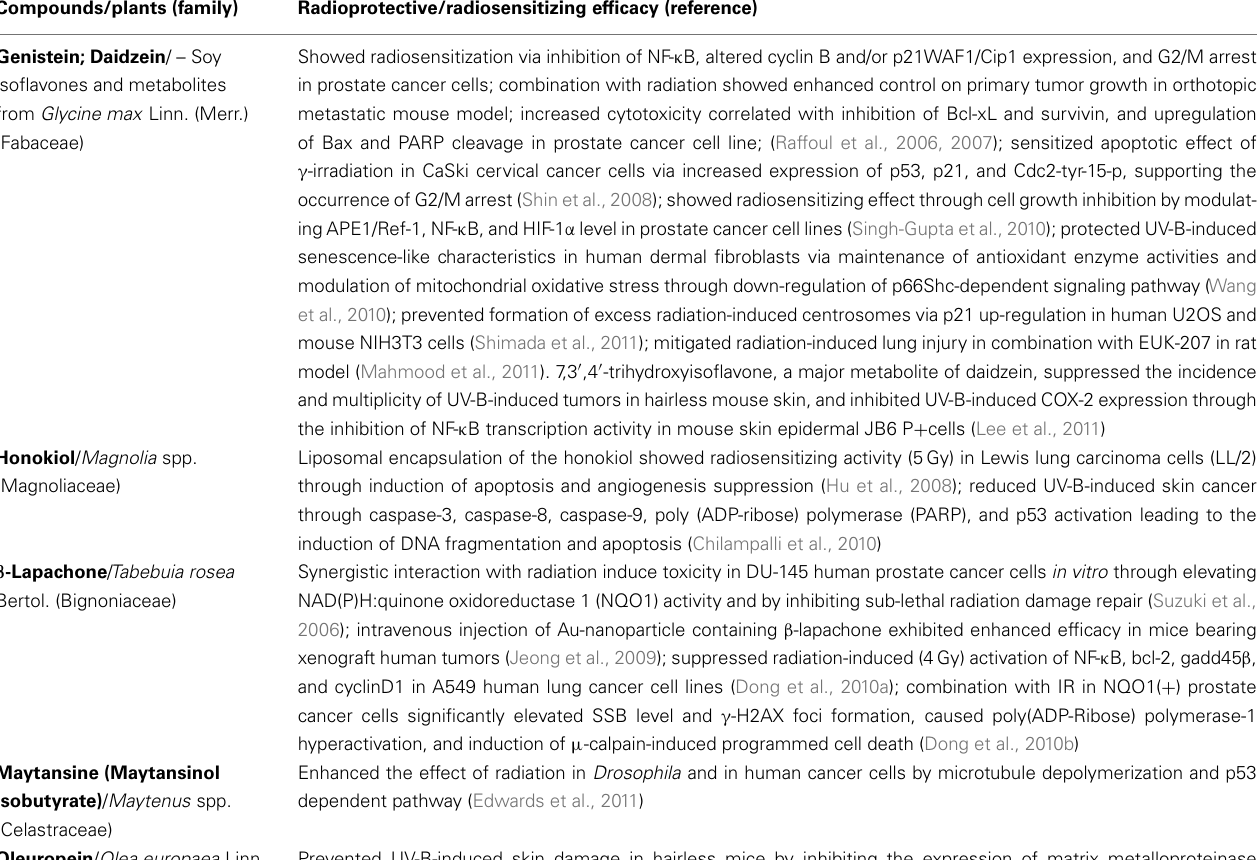
Compounds/plants